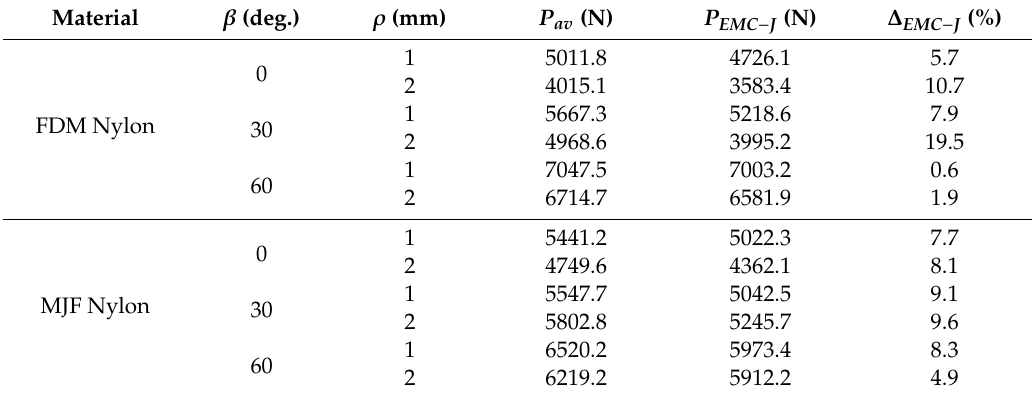
Table 4. Calculated critical load for studied 3D-printed specimens by means of EMC-J